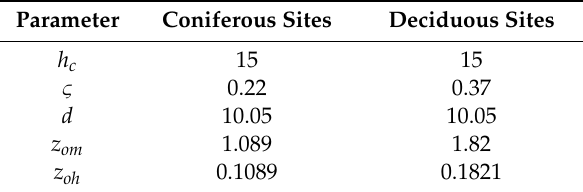
Table A1. Steady parameters in the calculation of the aerodynamic resistance to heat and vapor transfer, r a . All parameters are reported in meters, with exception of ς , which is